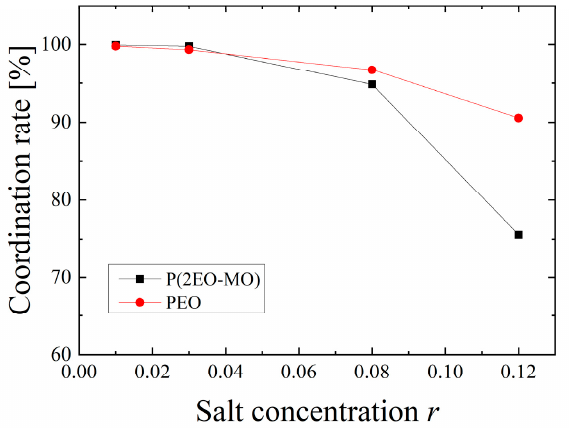
Figure 5. Oxygen coordination rate of Li ions.